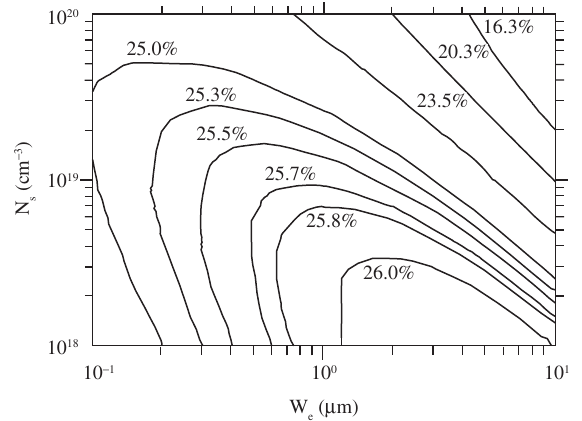
Figure 11. Solar cell efficiency contour plot, η (%) versus the emitter surface doping concentration, N